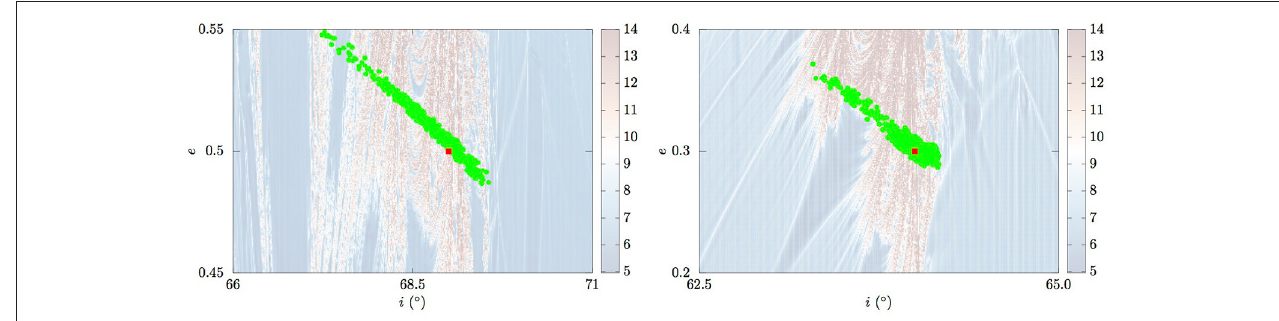
FIGURE 9 | Two diffusive scenarios illustrating transport scenarios along resonances in the regime of small perturbative parameters. The red spot indicates the initial condition where the ensemble of initial conditions are defined. Points of the orbits that return sufficiently close to the section (on which the FLIs appear as a background) are depicted with a green point. See text for